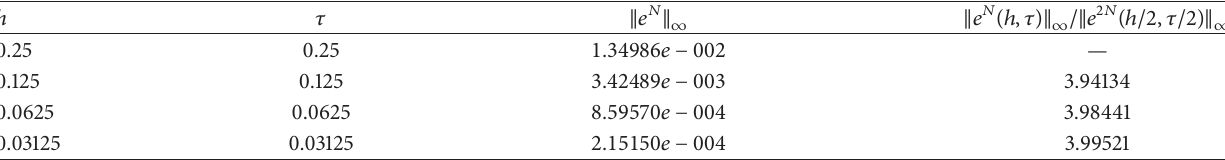
Table 1: The errors estimated in the sense of 𝐿 ∞ for 𝑝 = 3 at 𝑇 = 40 .